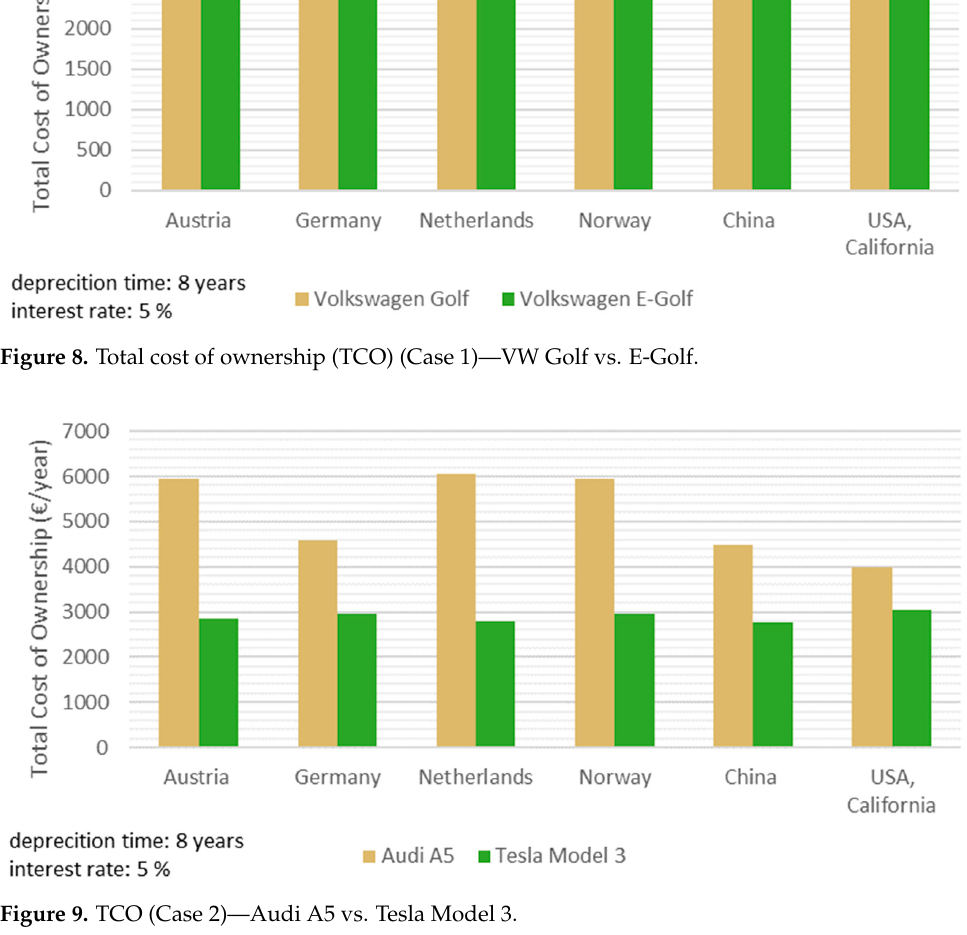
Figure 9. TCO (Case 2)—Audi A5 vs. Tesla Model 3.